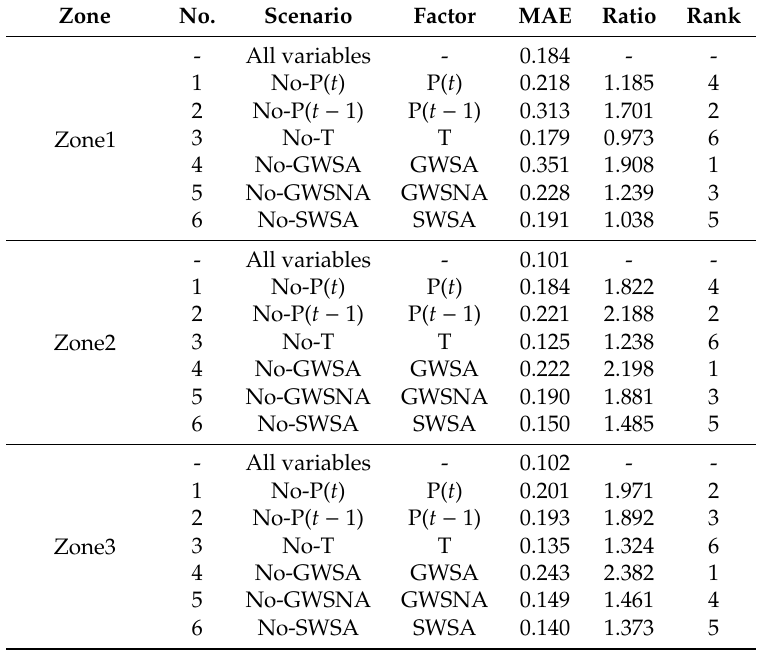
Table 6. The sensitivity analysis results of impact factors for monthly average GWL.